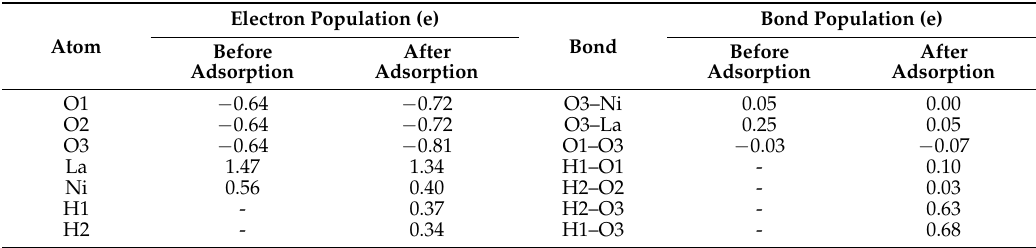
Table 3. The calculated electron populations and bond populations of LaNiO 3 (001)/H 2 on T3. T3 represents the adsorption site of H 2 molecule in the O